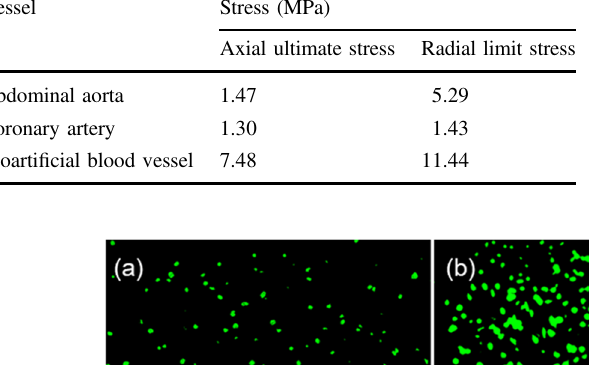
Table 1 Tensile strength of bioarti fi cial blood vessel Vessel